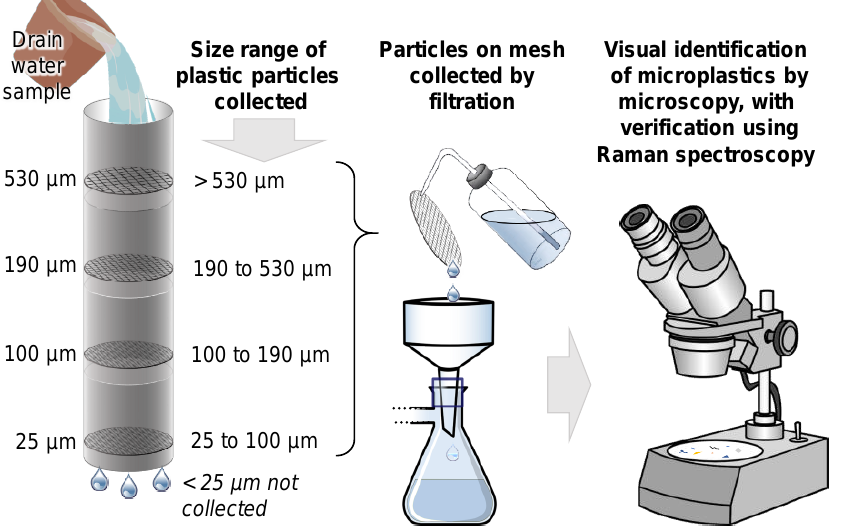
Figure 2. Stacked filter design and schematic of microplastic separation and counting procedures. Sampled water is passed through the filter stack so that microplastics are sorted according to size classification. The filtered water is discarded. Particles on each mesh filter are transferred quantitatively onto glass fibre filters for microscopic identification and counting.